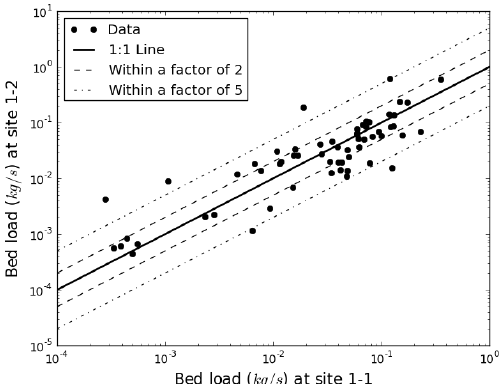
Fig. 5. Comparison between the bed load rates measured at sub- sites 1 and 2 on the Urumqi River during the summer 2006. The solid line corresponds to perfect agreement, the dashed lines corre- spond to 2:1 and 1:2 ratios, respectively and the dotted-dashed lines correspond to 5:1 and 1:5 ratios uncertainty